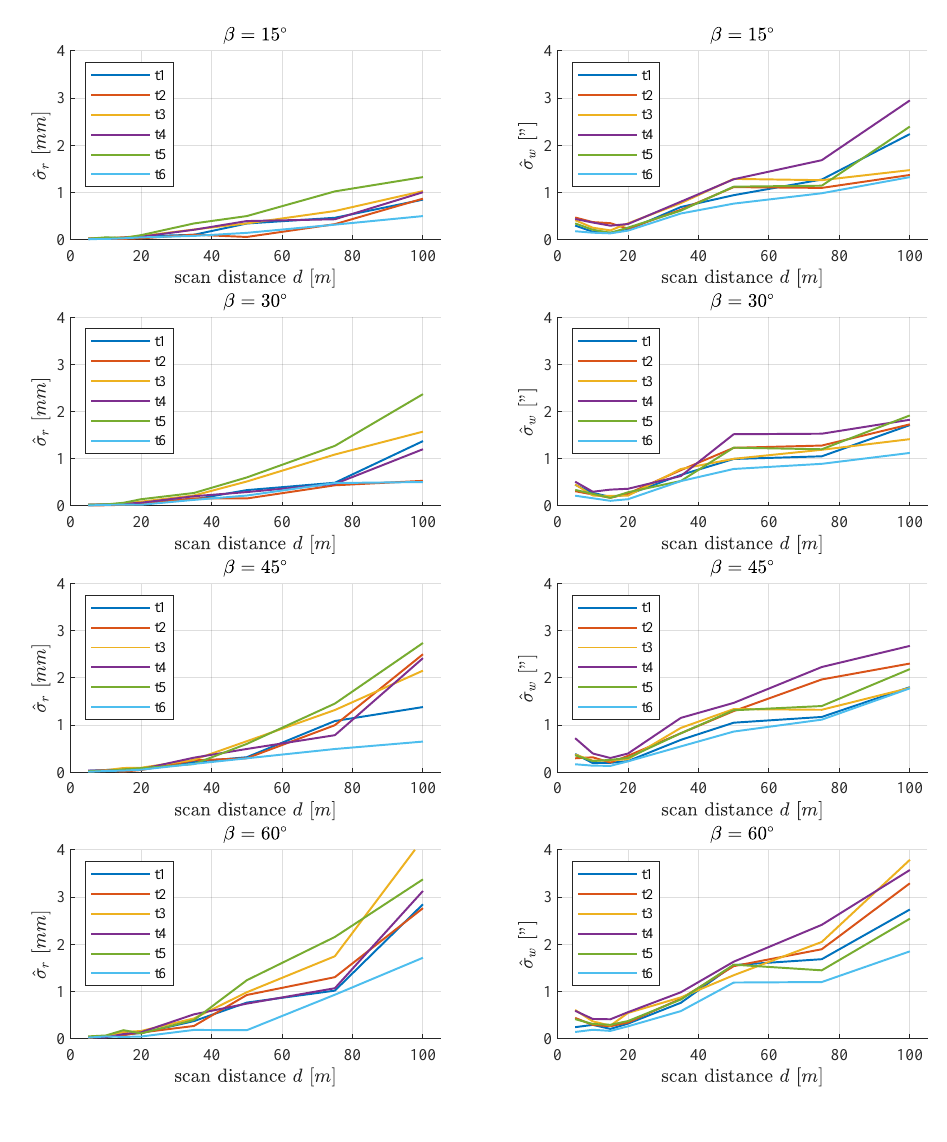
Figure 9. Standard deviations in distance direction ˆ σ r and angular direction ˆ σ w for different